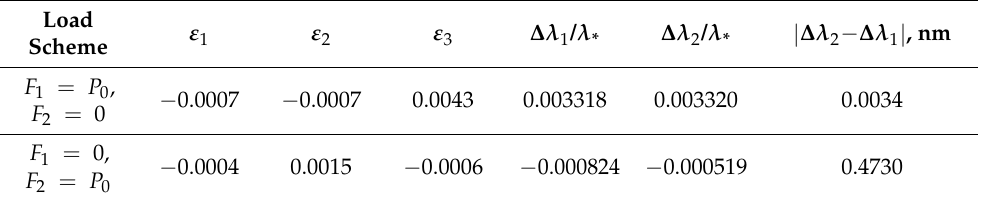
Figure 4. PCM models with embedded optical fiber: without resin pocket ( a ) and with resin pocket ( b ). Table 1. The results of numerical calculations of strain values and resonant wavelength shift for PCM model with embedded optical fiber without resin